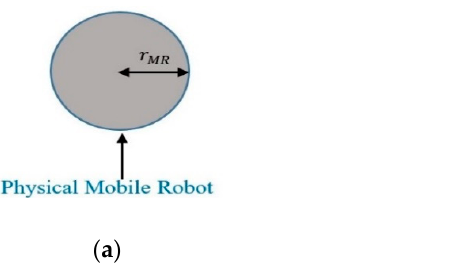
Figure 6. Expanding obstacles size corresponding to the mobile robot size: ( a ) physical robot; ( b ) grid shaped obstacle.